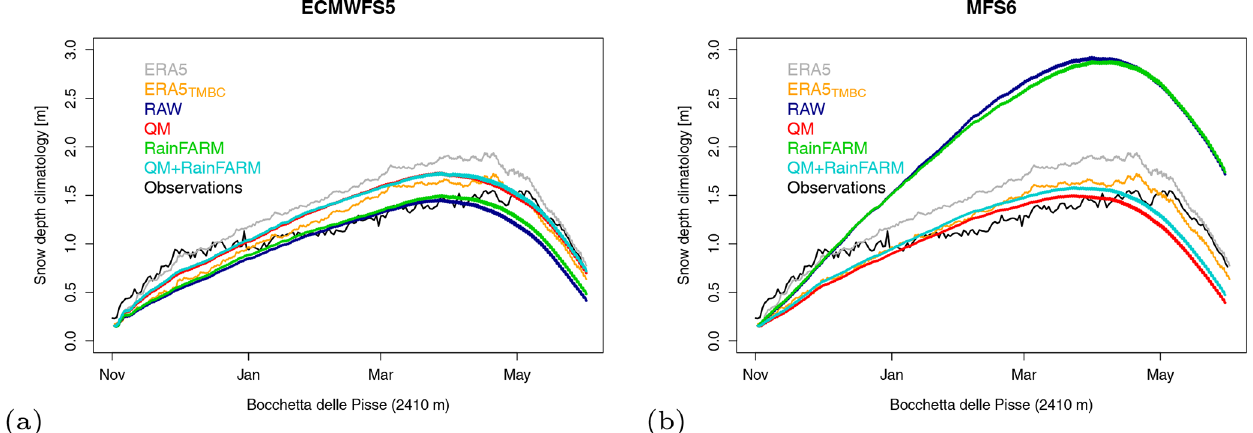
Figure 5. Daily snow depth climatology for the period 1995–2005 as simulated by the SNOWPACK model forced by ERA5 when using (grey) raw and (orange) bias-corrected air temperature, as well as by (a) ECMWFS5 and (b) MFS6 seasonal forecast data with different precipitation input (RAW, QM, RainFARM and QM + RainFARM) as specified in Table 3, for the site of Bocchetta delle Pisse. Observations are reported in black for